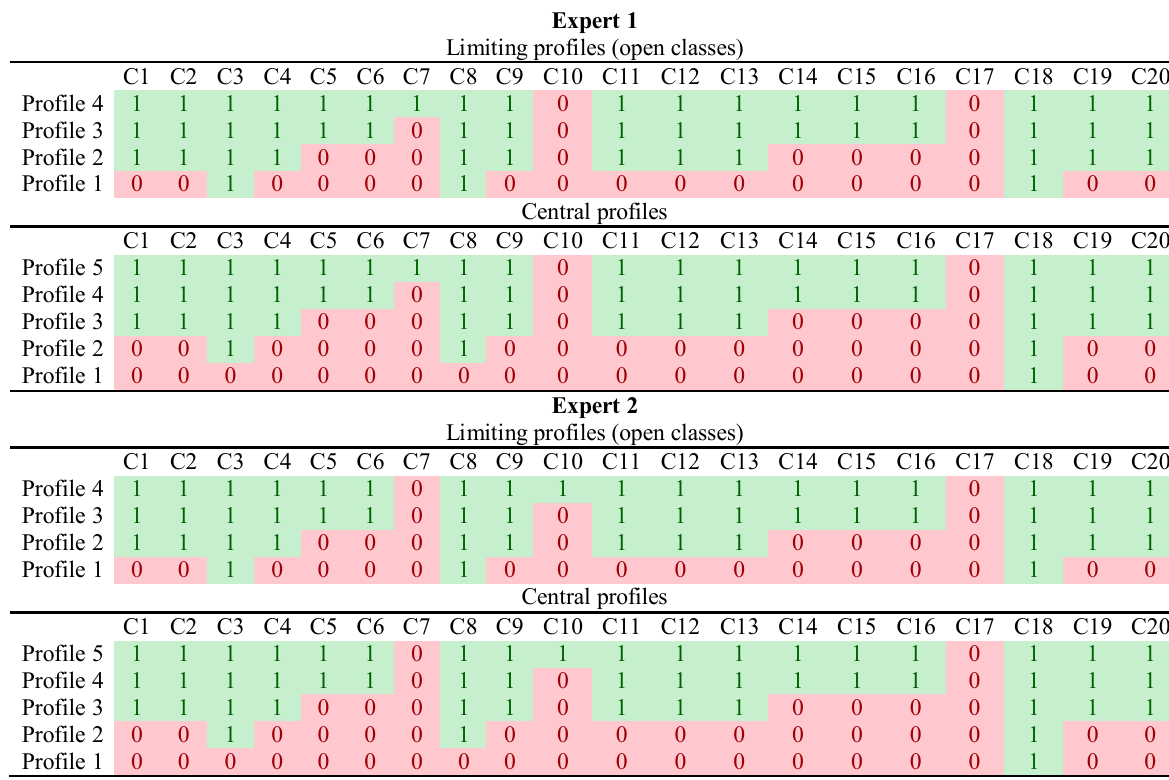
Limiting (open classes) and central profiles elicited from two experts and performance profiles of the mutual